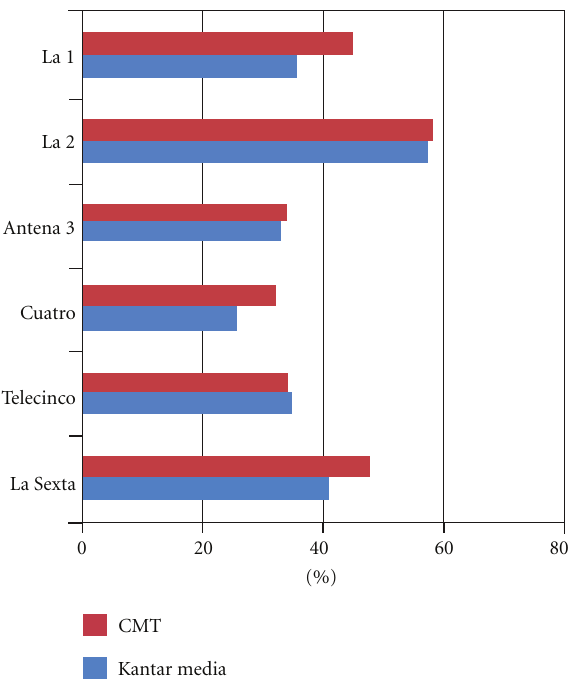
Figure 1: Average percentages of subtitling in the main DTT channels in Spain in 2009. Comparison of sources: CMT and Kantar Media (elaborated by the authors).